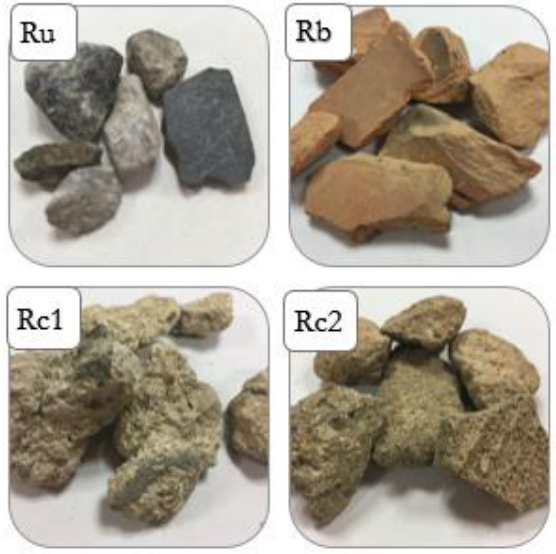
Figure 2. Main RA constituents. Figure 2. Main RA